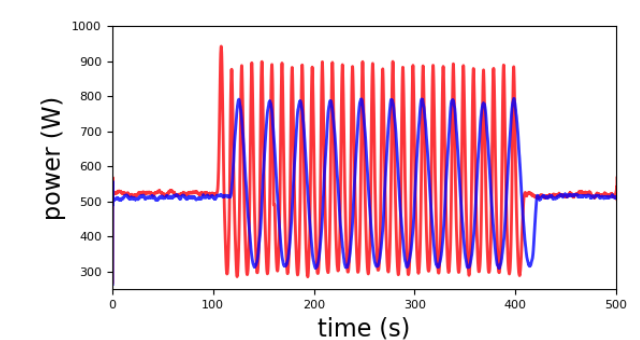
Figure 6. The power output time series for test 1 (red) and test 3 (blue).